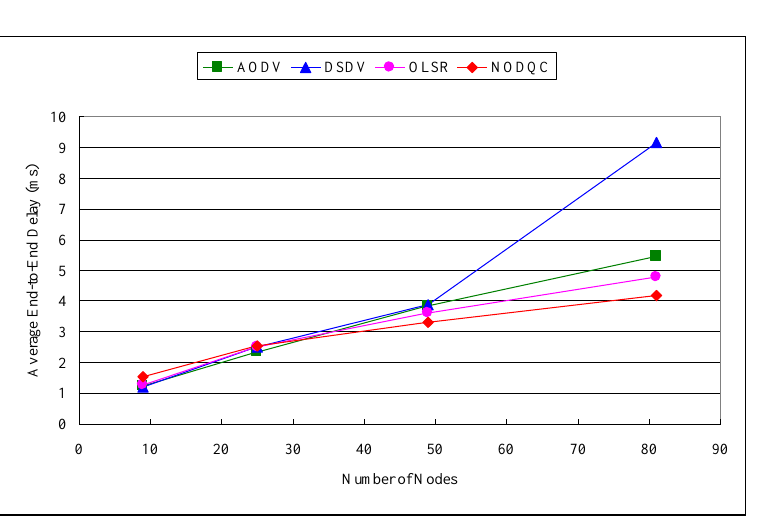
Figure 6. Experiment results of routing algorithms (average end-to-end